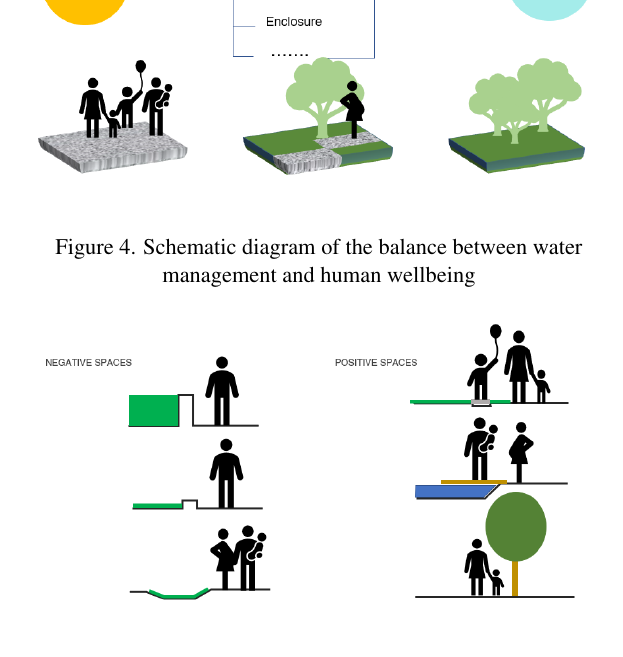
Figure 5. Schematic diagram of spatial